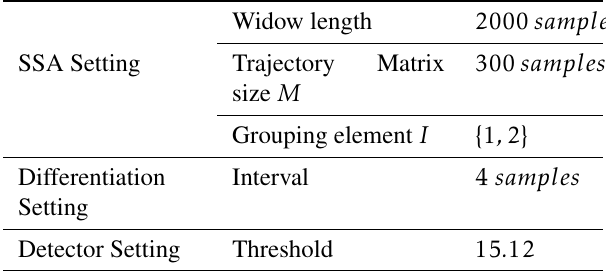
Table 2. Off-line Detector